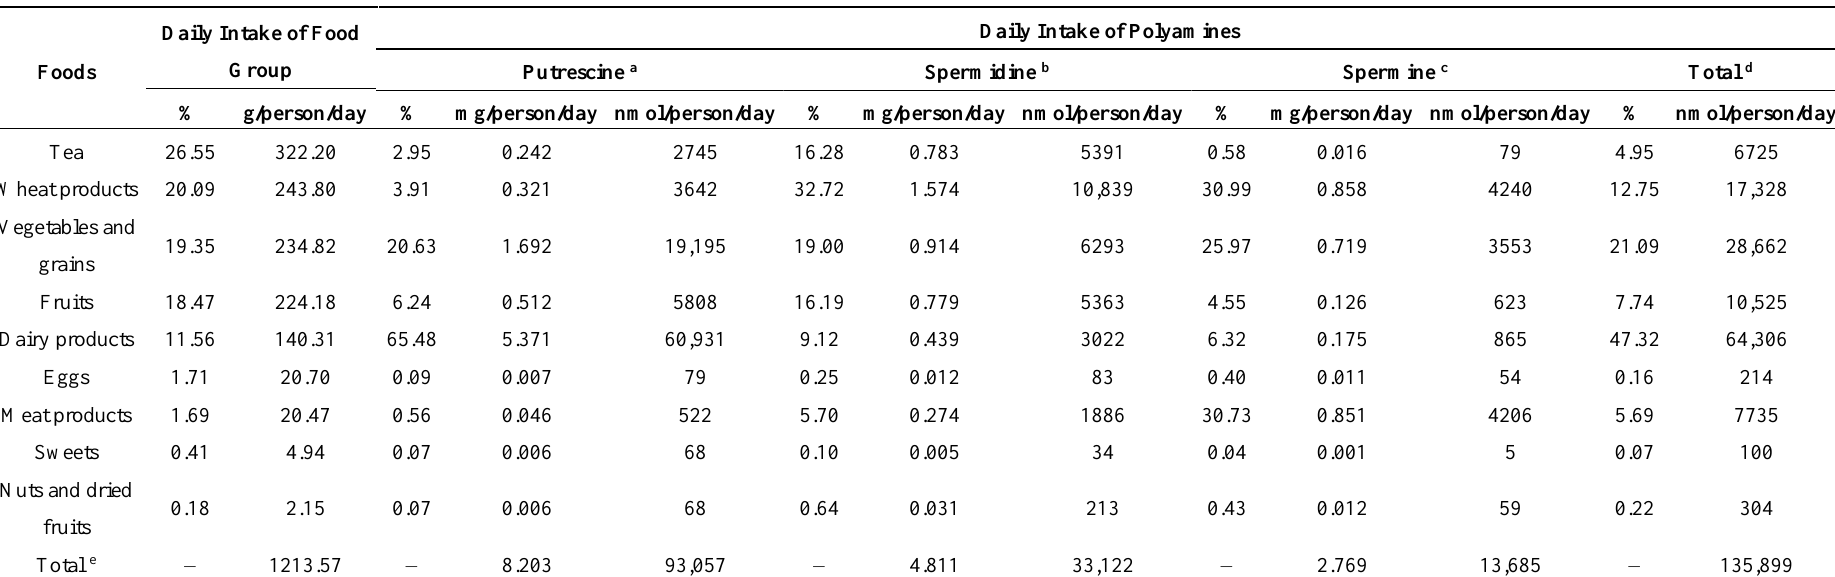
Table 2. Daily intake of polyamines in food groups among the Turkish